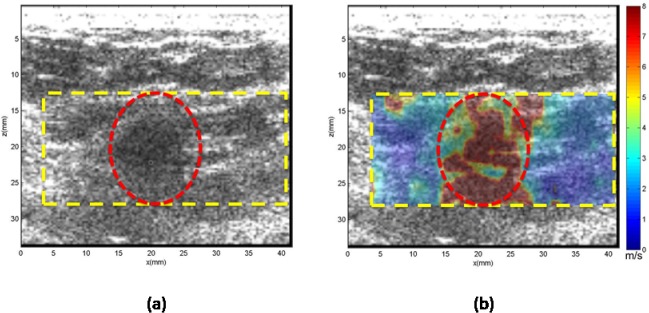
US and CUSE shear wave speed map of breast tissue (dashed yellow contour) including the breast mass ROI (red dashed contour).(a) B-mode US image. (b) CUSE shear wave speed map.